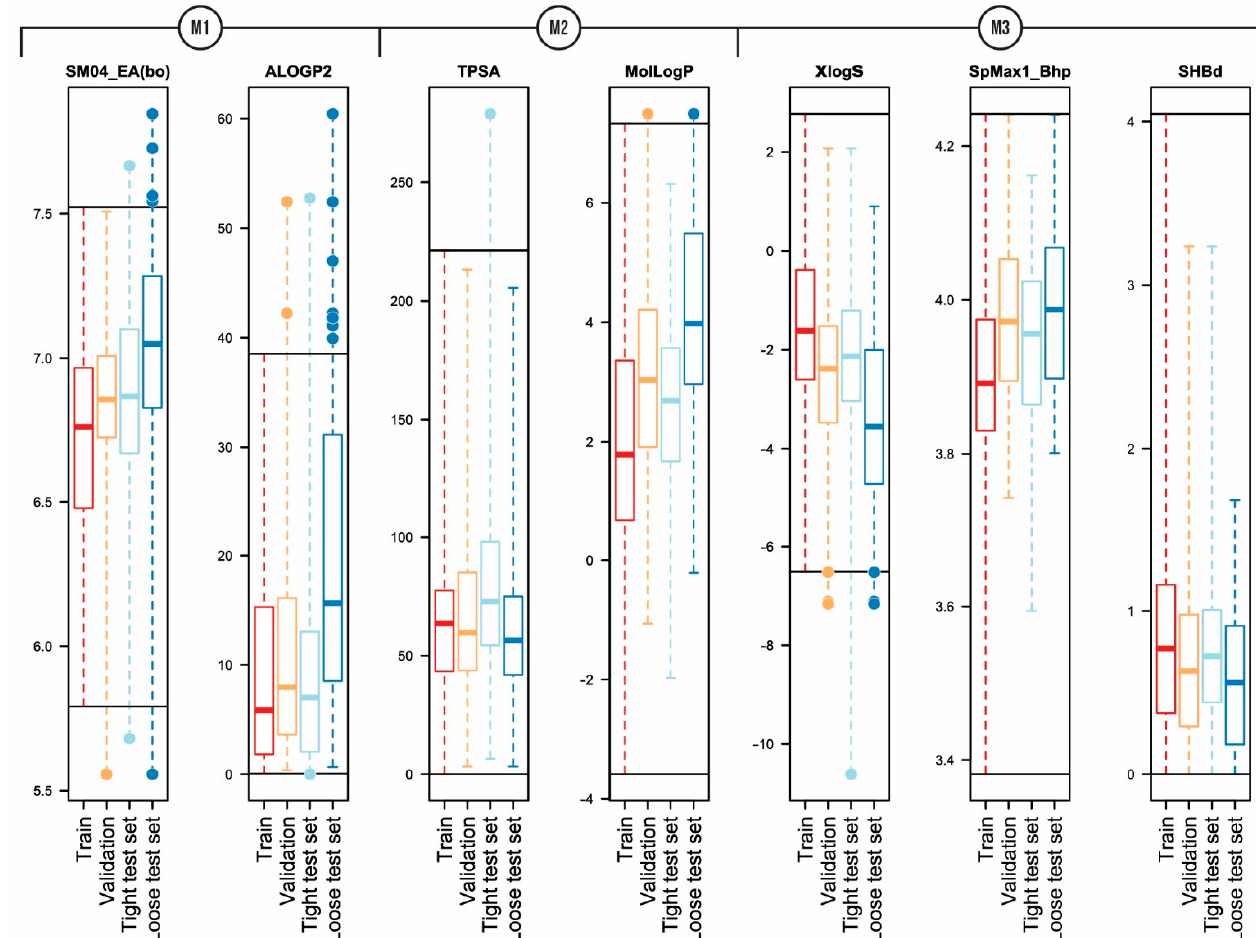
Figure 2. Comparison of descriptor ranges and distributions for training, validation, and test data sets of models ( M1 – M3 ). The horizontal solid line corresponds to the minimum and maximum values of the training data set.